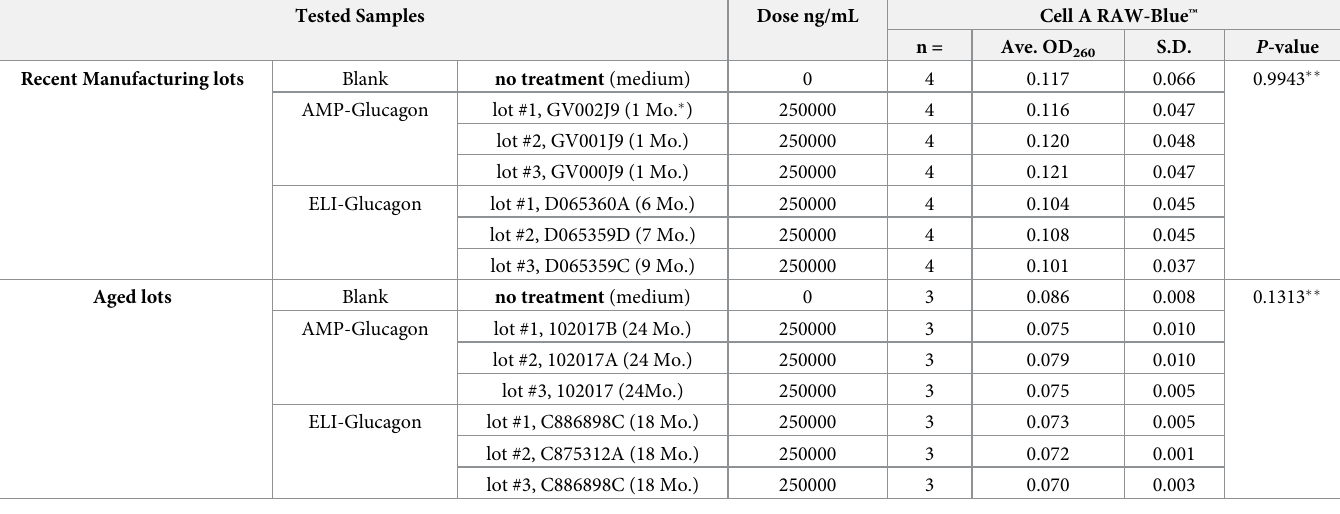
Table 3. Innate immunity assay of glucagon products with RAW-Blue TM . Tested